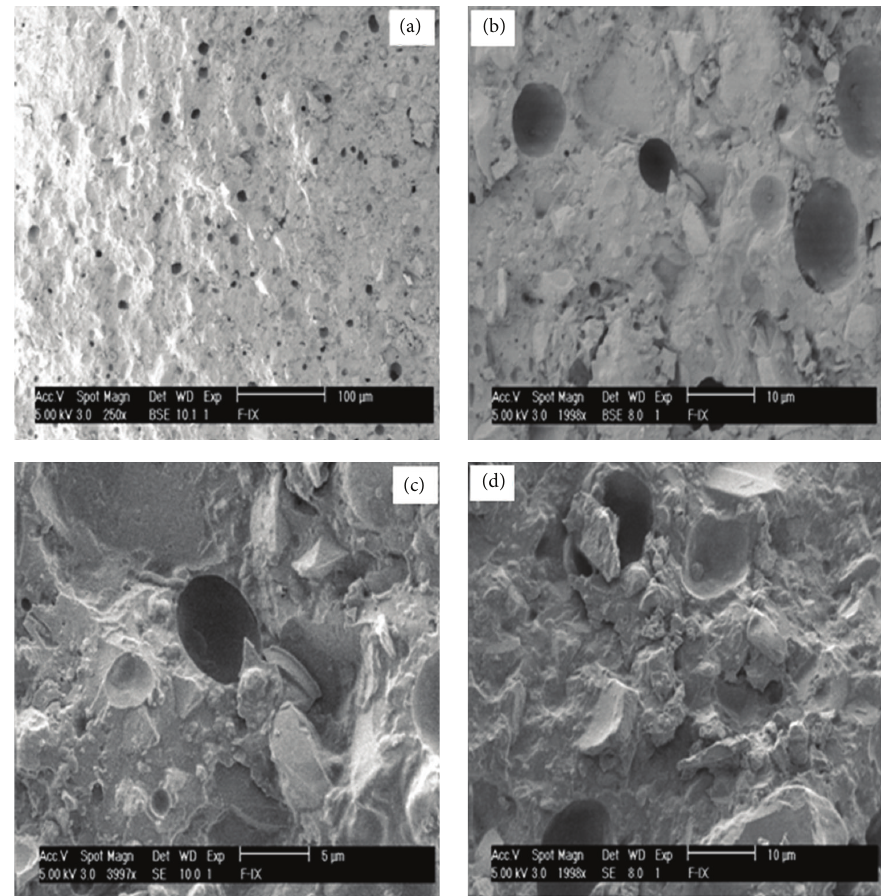
Figure 5: Cryo-SEM micrographs of the fractured surface of GIC at various magnifications demonstrating (a) micrograph at lowest magnification ( × 250) showing the absence of the cracks and ((b), (c), (d)) micrographs at high magnifications ( × 1998 and × 3997) indicating the presence of pores, glass particles, and the matrix phase of